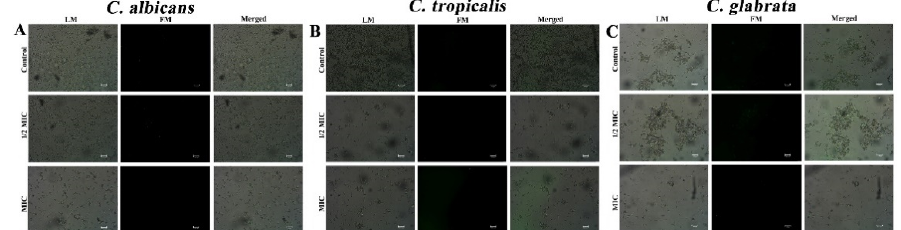
Figure 4. Assessment of intracellular ROS levels in candida cells such as ( A ) C. albicans , ( B ) C. tropicalis and ( C ) C. glabrata using DCFH ‐ DA. LM—light microscopic images; FM—florescence micrograph; merged—merged fluorescence and light micrograph. Magnification—200×; scale merged—merged fluorescence and light micrograph. Magnification—200 × ; scale bar—50 µ bar—50 μ m.